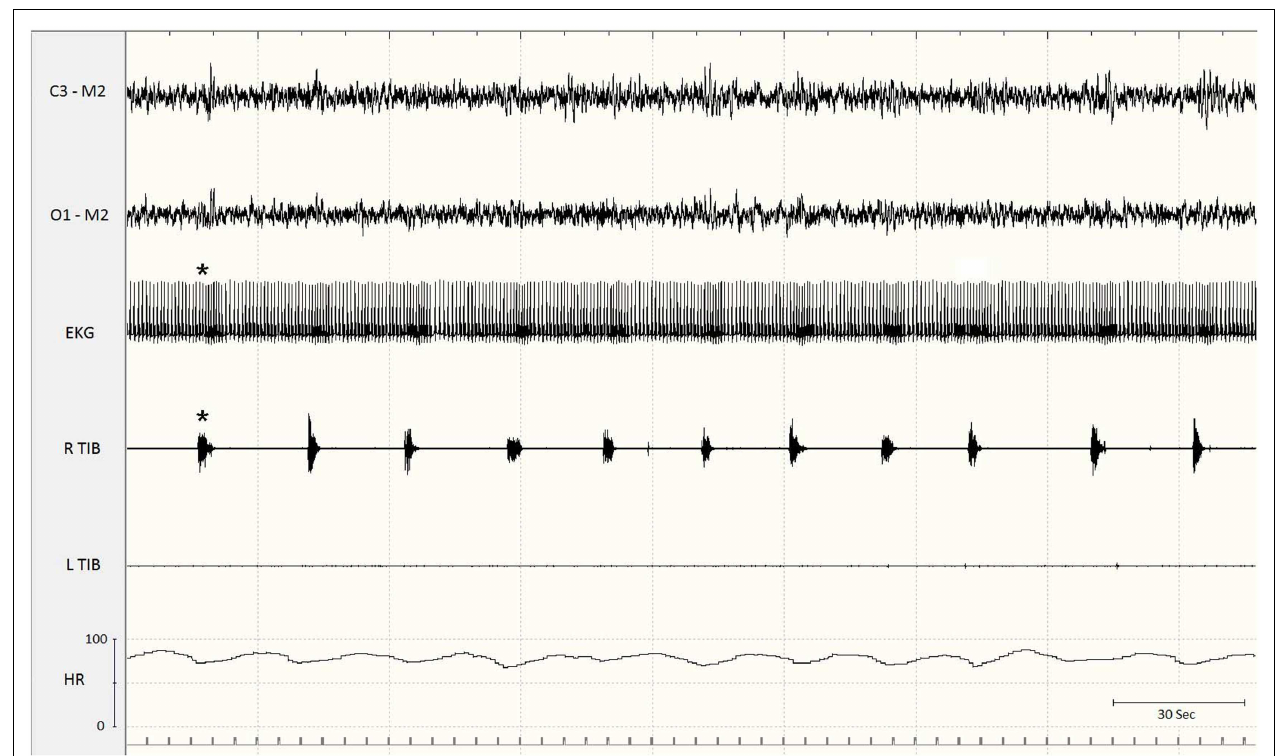
FIGURE 2 | Excerpt of a polysomnographic tracing at a low paper speed . Note the association of periodic limb movements with increases in heart rate (asterisks). EKG, electrocardiogram;Tib, tibialis anterior; R, right; L, left; HR, heart